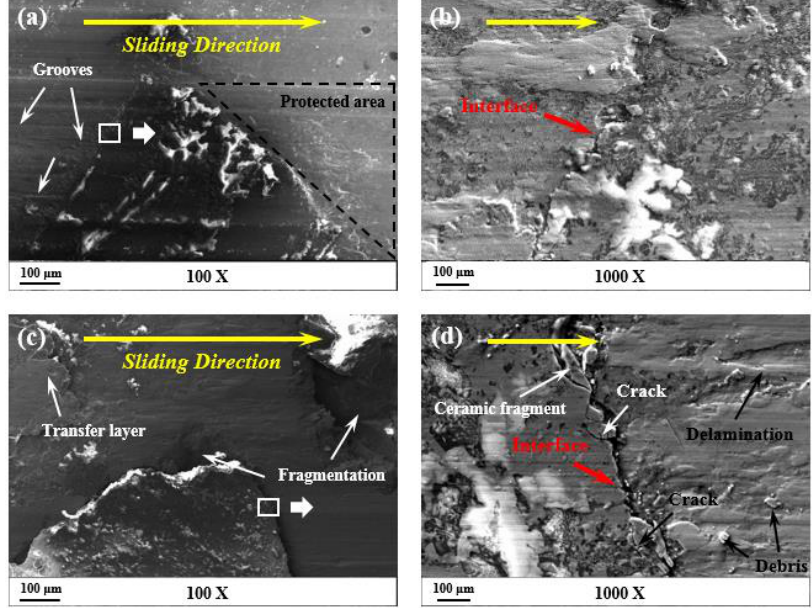
Figure 9. The worn surface morphologies of the composite under different loads: ( a ) 300 N-low magnification; ( b ) 300 N-high magnification; ( c ) 900 N-low magnification; ( d ) 900 N-high magnification.